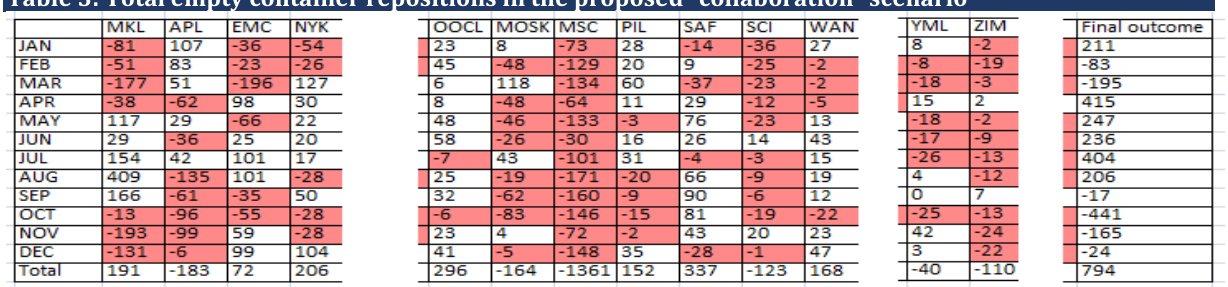
Table 3: Total empty container repositions in the proposed “collaboration” scenario